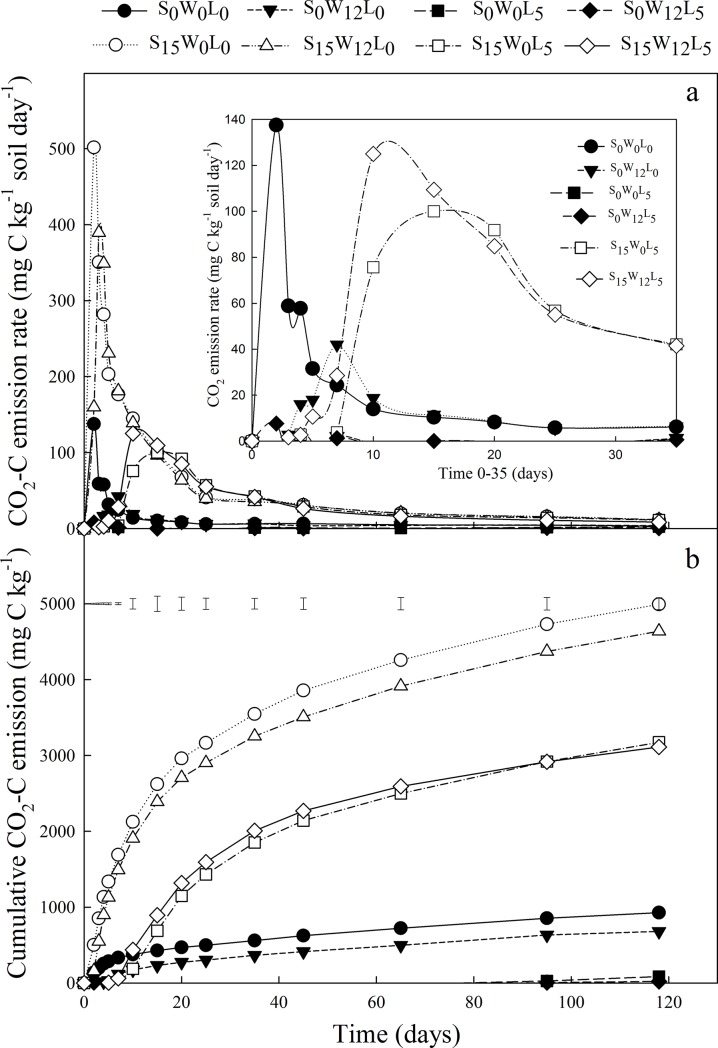
Effects of the amendment rates of straw and lime on dissolved organic carbon (DOC) and soil pH.S0L0, including S0W0L0 and S0W12L0; S15L0, including S15W0L0 and S15W12L0; S0W0L5, including S0W0L5 and S0W12L5; S15W0L5, including S15W0L5 and S15W12L5. The error bars outside the curve represent LSD.